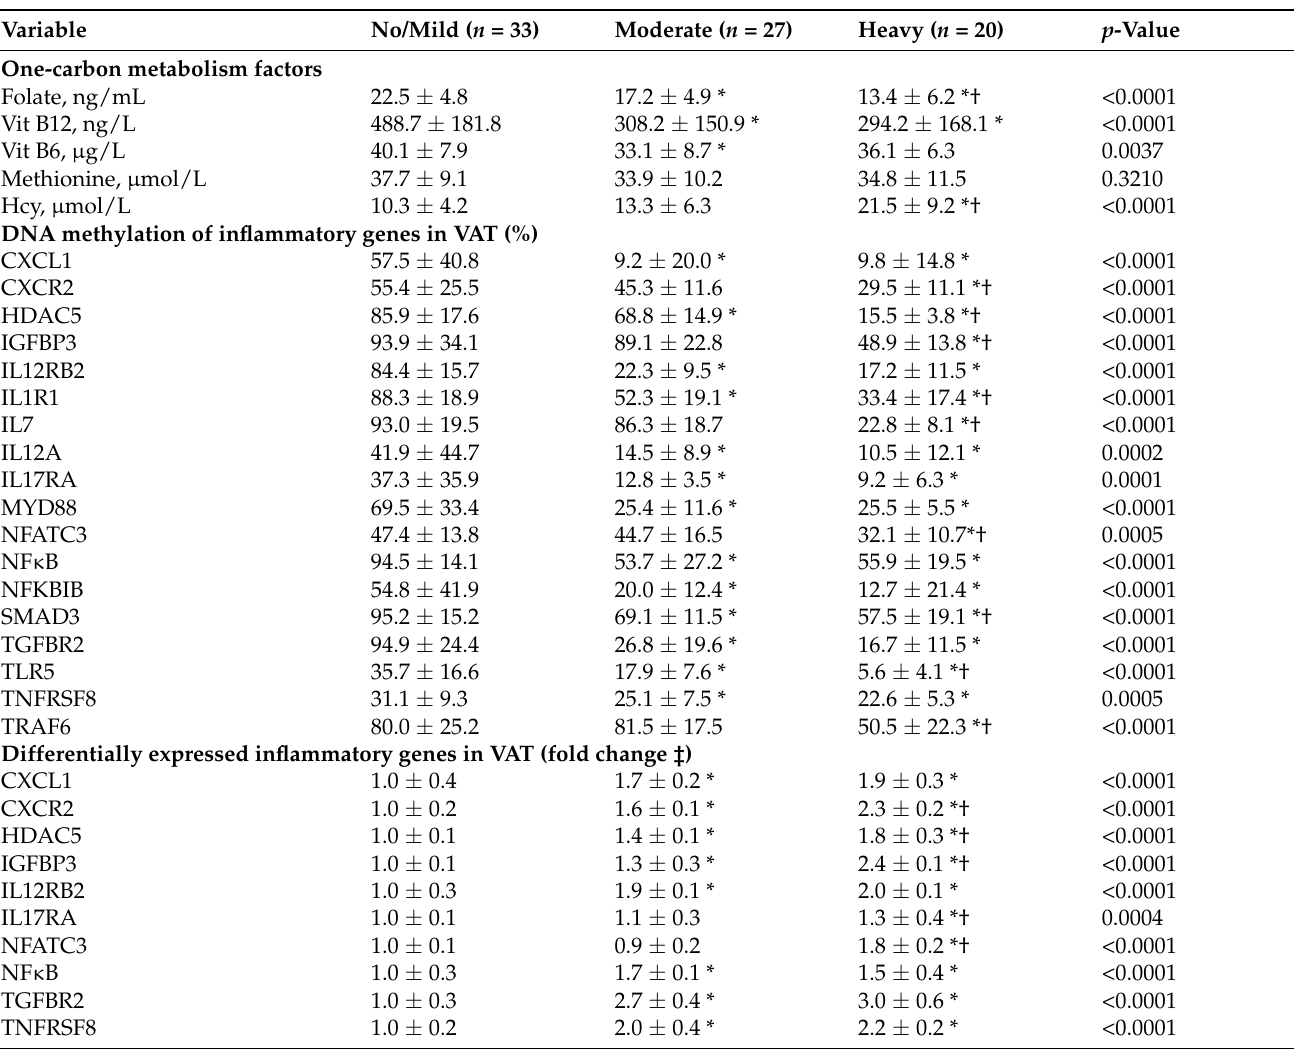
Table 2. DNA methylation and expression of inflammatory